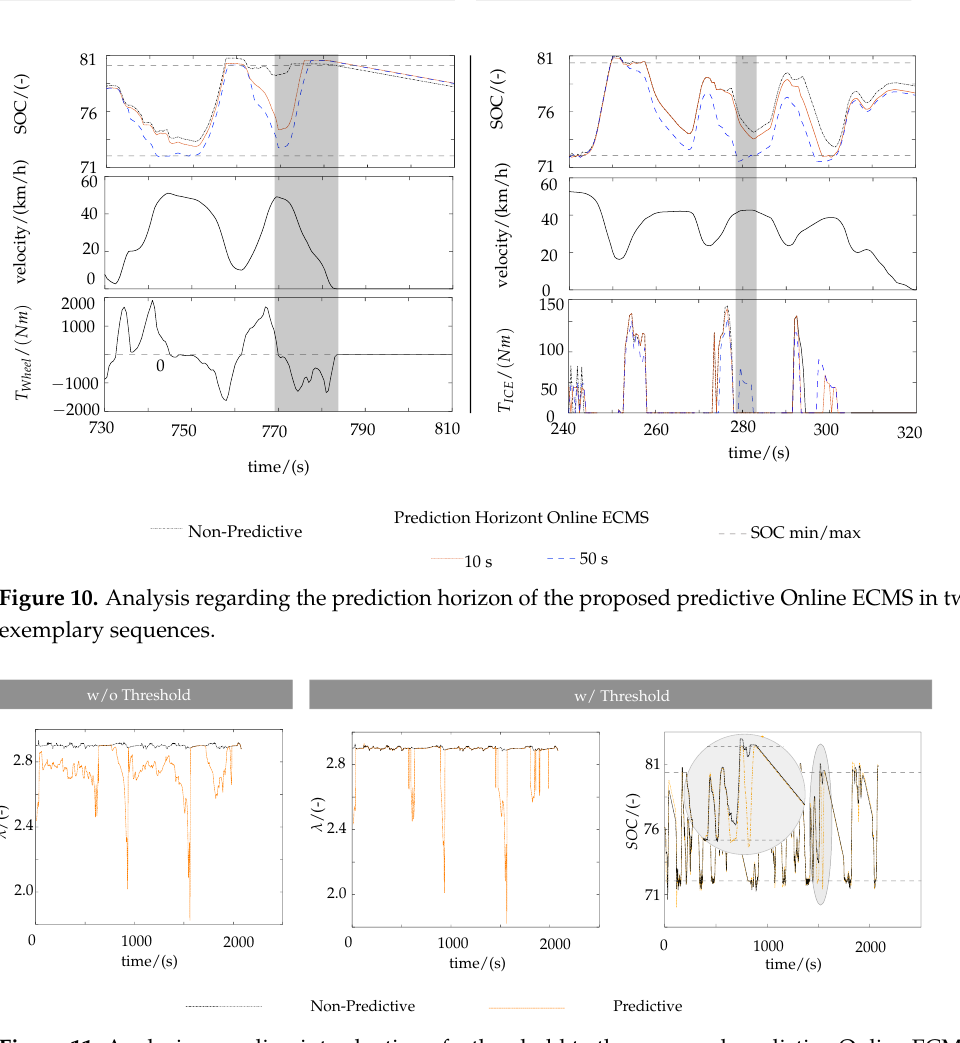
Figure 11. Analysis regarding introduction of a threshold to the proposed predictive Online ECMS, without and with threshold. Non-predictive Online ECMS (black) and predictive Online ECMS (orange). Considering recuperation potential as introduced in Equation (10) results in a continuous reduction in λ without any further measures (see without threshold) for the predictive Online ECMS (orange).